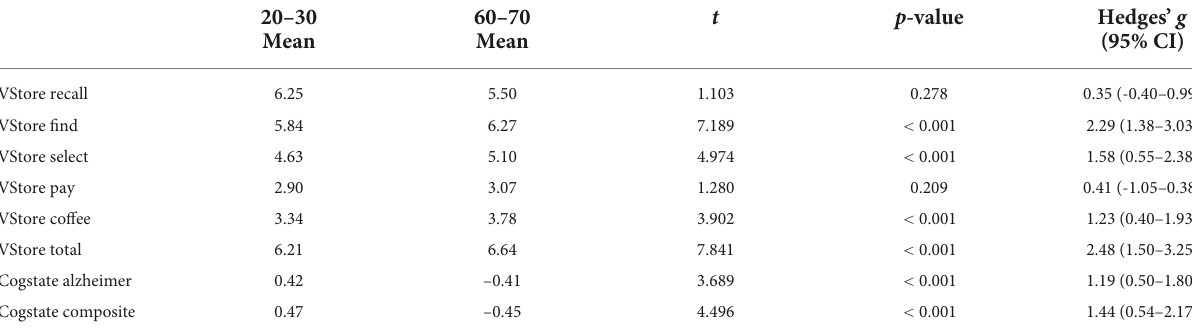
TABLE 4 Group differences in cognitive performance between participants aged 20–30 vs.